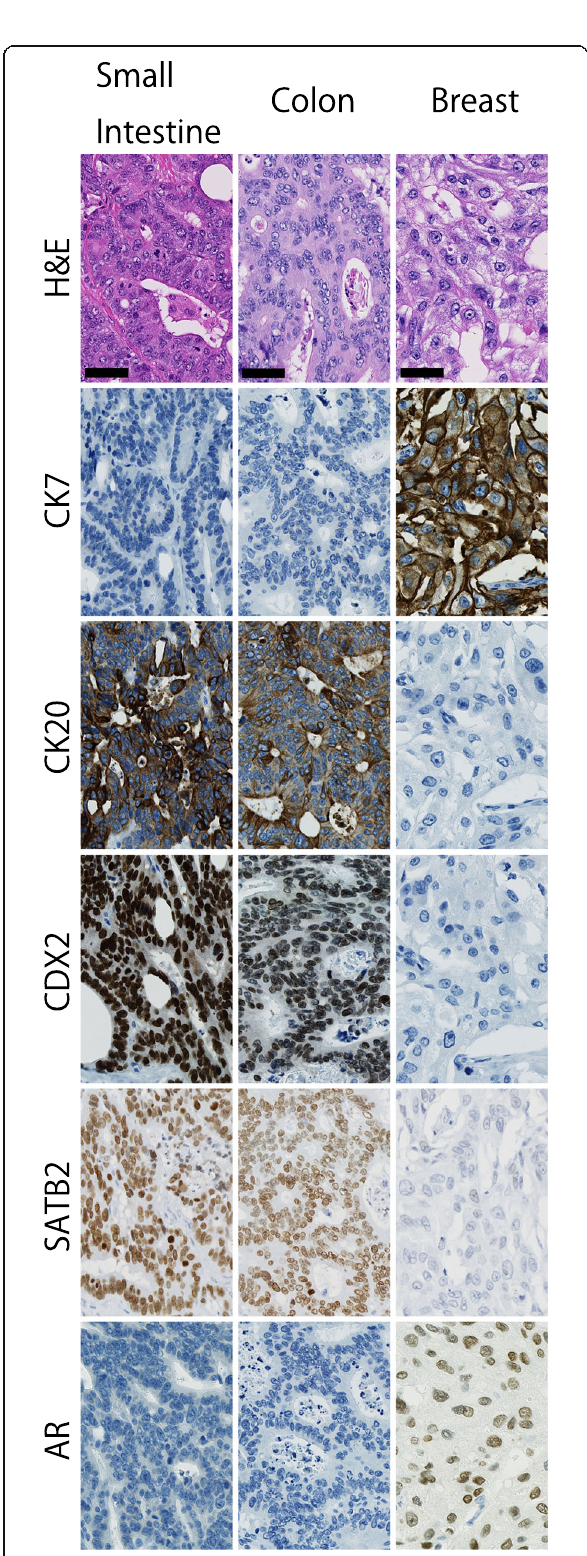
Fig. 3 Expression of cytokeratins 7/20 and transcriptional factors in the small intestinal, colon, and breast cancer. Black bars: 50 μ